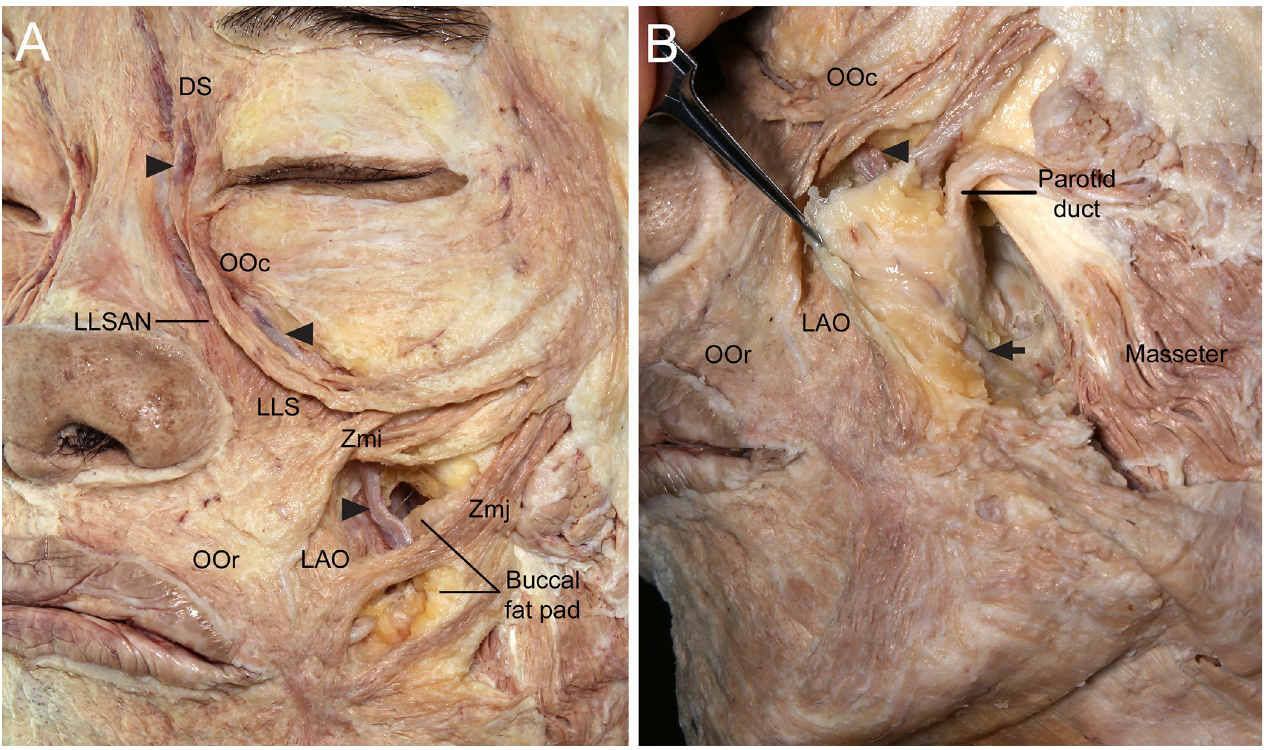
Fig 4. Course of the angular vein (arrowheads) in relation to the buccal fat pad in the lower face. (A) The angular vein coursed deep to the Zmj and lateral to the LAO. It passed through the anterior lobe of the buccal fat pad. Some of the buccal fat pad surrounding the angular or facial vein was removed to reveal those veins. (B) The anterior lobe of the buccal fat pad was reflected in the anterior view to show its posterior surface surrounding the angular or facial vein (arrow) and the parotid duct. The anterior lobe of the buccal fat pad was covered by the capsule, which divided it from the other lobes.